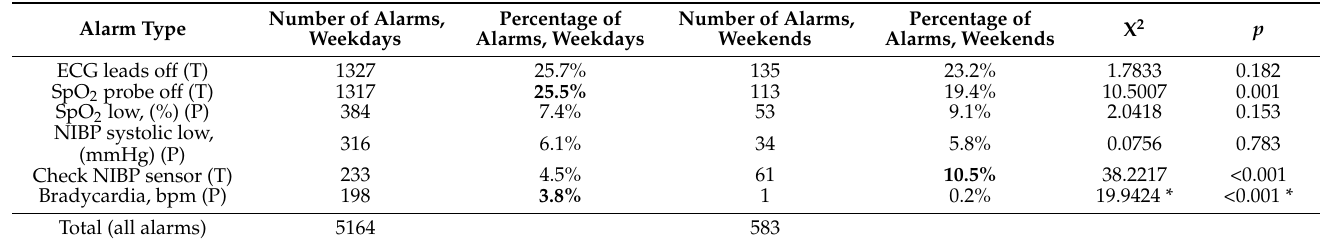
Table 3. Differences in alarm types between weekdays and weekends for the three most common physiological and technical alarms using chi-squared test. (Only SpO 2 , ECG, and NIBP sensor alarms were included).